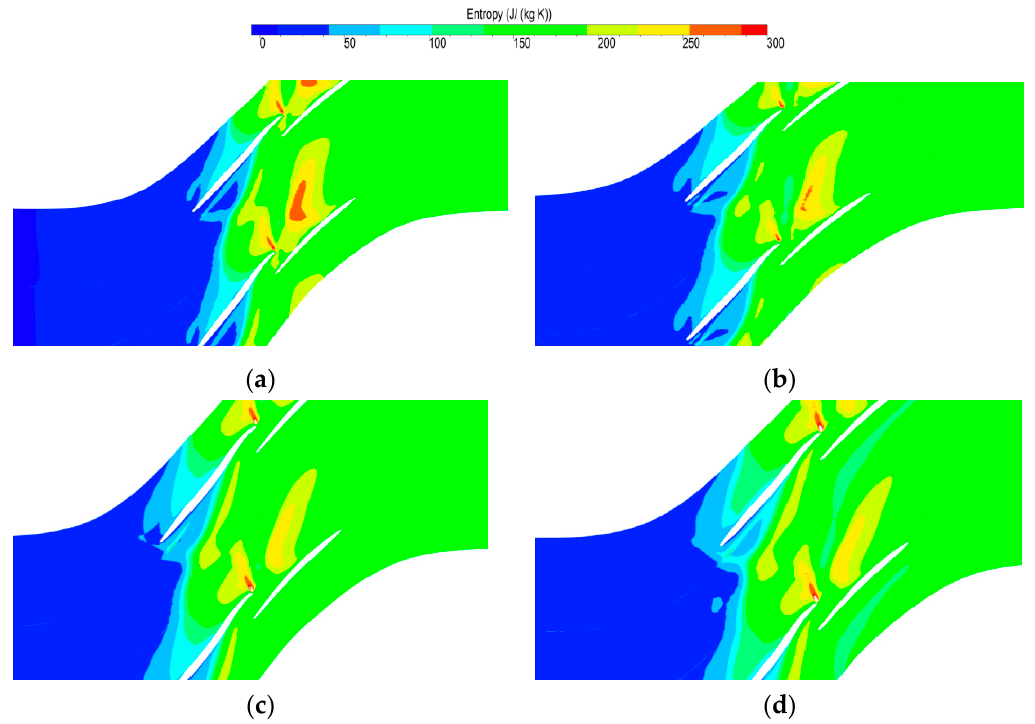
Figure 22. Comparison of the entropy diagram of the casing wall of PB10, PB20, and PB30. ( a ) ORG. ( b ) PB10. ( c ) PB20. ( d )